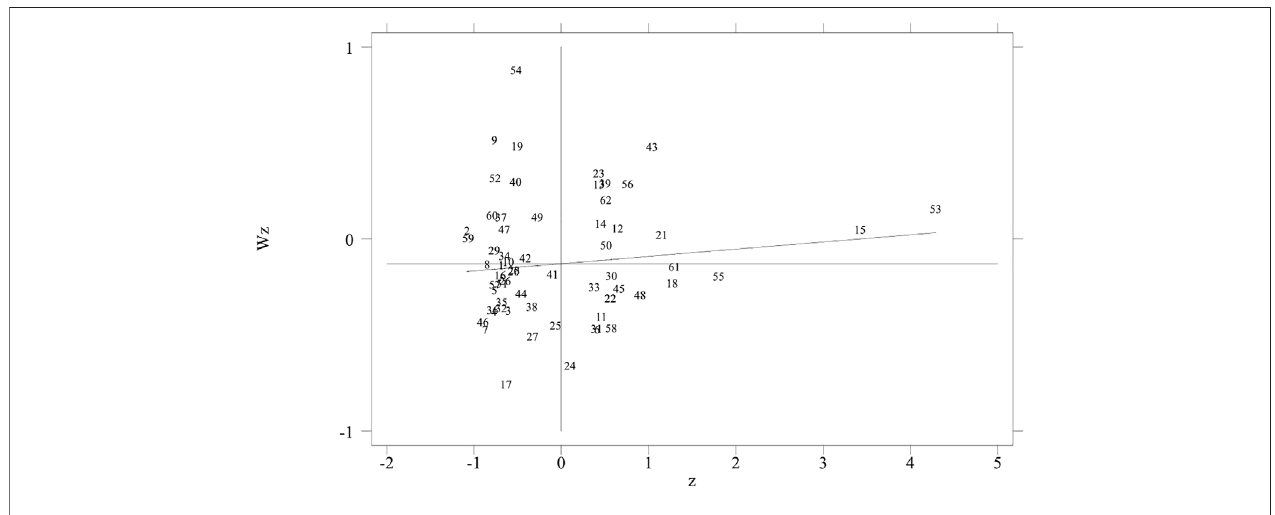
FIGURE 5 | Moran scatter plot of eco-ef fi ciency in 2009.